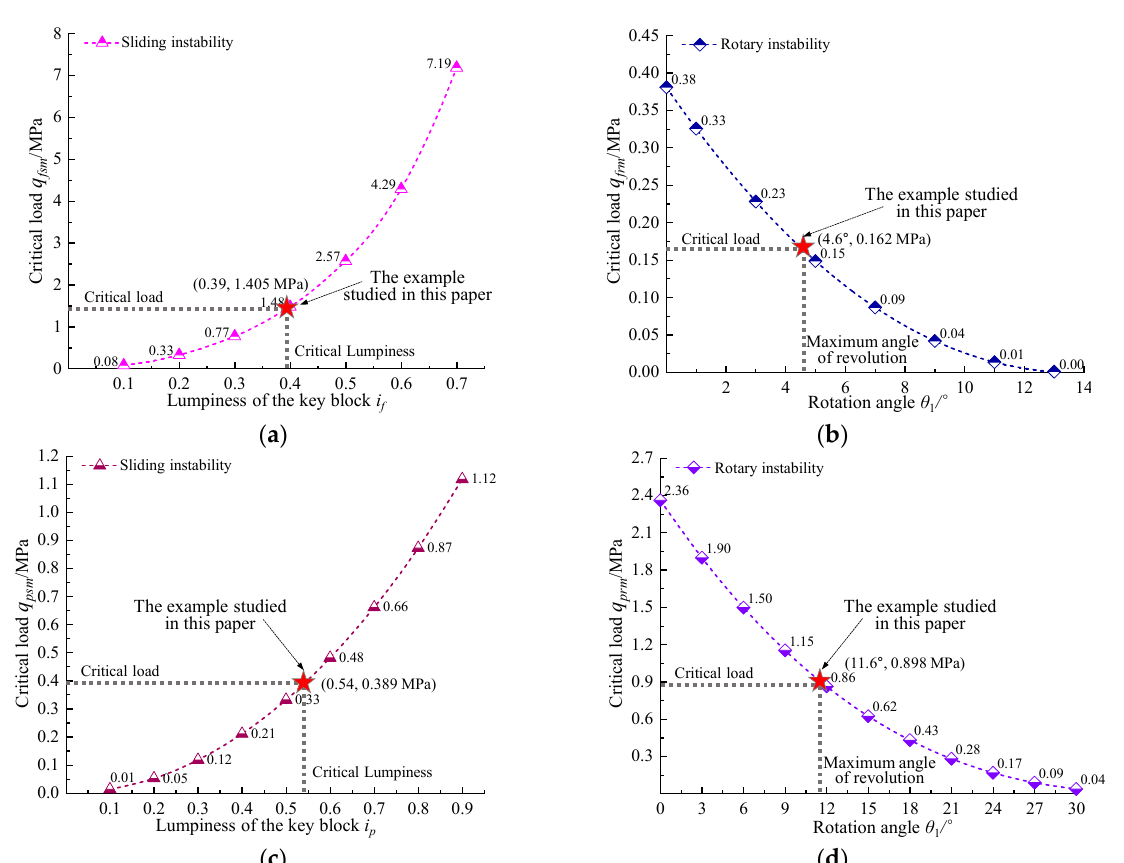
Figure 16. Stability analysis of the first and periodic fracture of the damaged main roof. ( a ) Sliding instability during the first fracture ( b ) Rotary instability during the first fracture ( c ) Sliding instability during the periodic fracture ( d ) Rotary instability during the periodic fracture.